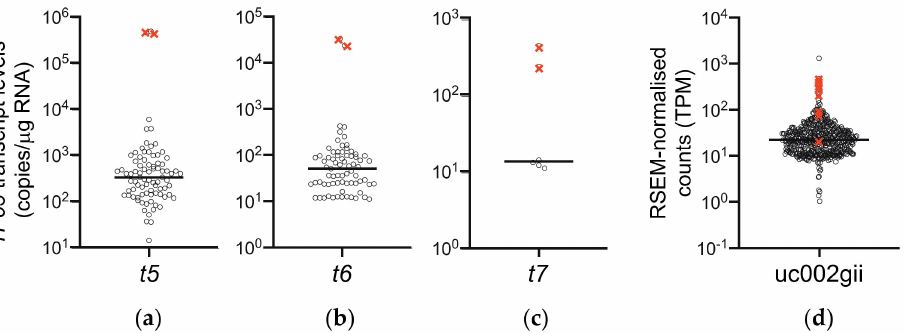
Figure 4. Scatterplots showing levels of transcripts encoding ∆ 133p53 isoforms in Breast Cancer cohorts. ( a – c ) Results from long amplicon ddPCR of 85 NZ breast cancer samples with both known TP53 mutation status and TP53 transcript expression data. ( a ) LRG_321t5 encoding ∆ 133p53 α (detectable in 83/85 tumors), ( b ) LRG_321t6 encoding ∆ 133p53 β (detectable in 73/85 tumors), ( c ) LRG_321t7 encoding ∆ 133p53 γ (detectable in 6/85 tumors) and ( d ) uc002gii TP53 transcript, assigned as encoding ∆ 133p53 α , quantitated by RSEM analysis of RNA-seq data in 727 TCGA BRCA samples with known TP53 mutation status (TPM = transcripts per million reads). Black circles represent tumor samples expressing this transcript; for clarity samples have been jittered on the x -axis. Tumors with a TP53 intron 4 splice site mutation are indicated by × . Horizontal line represents the median expression level for each cohort. Note that “detectable” refers to limit of detection of ddPCR assays, which is transcripts with abundance greater than 10 copies/ µ g